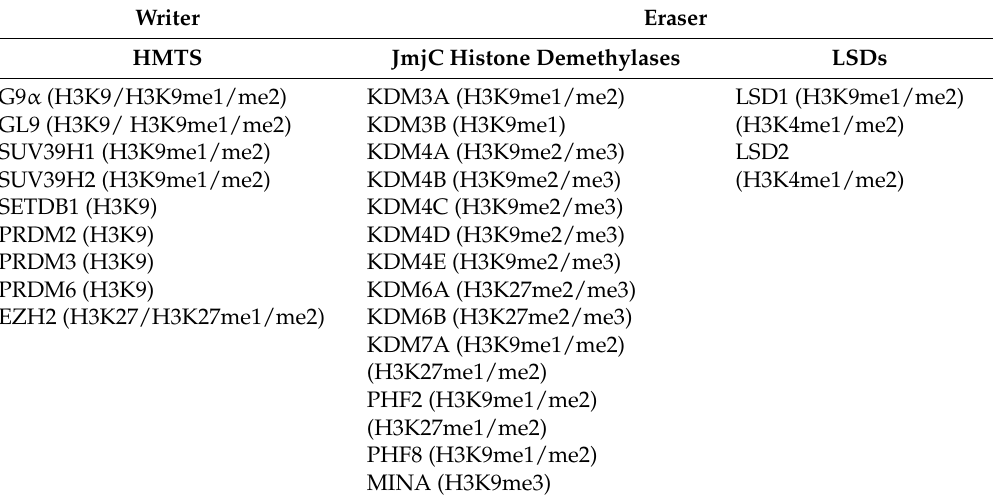
Table 1. Writers and erasers of H3K9 and H3K27 methylation. Histone Methytransferases (HMTs), Jumonji-C (JmjC) histone demethylases, and Lysine Specific Demethylases (LSDs) targeting H3K9 and H3K27 are shown (targets are in brackets). Euchromatic Histone Lysine Methyltransferase 2 (EHMT2, G9 α ), G9 α Like Protein 1 (GPL), Suppressor Of Variegation 3–9 Homolog (SUV39H), SET Domain Bifurcated 1 (SETDB1), PR/SET Domain (PRDM), Enhancer Of Zeste 2 Polycomb Repressive Complex 2 Subunit (EZH2), Lysine Demethylase (KDM), PHD Finger Protein (PHF), and Myc-Induced